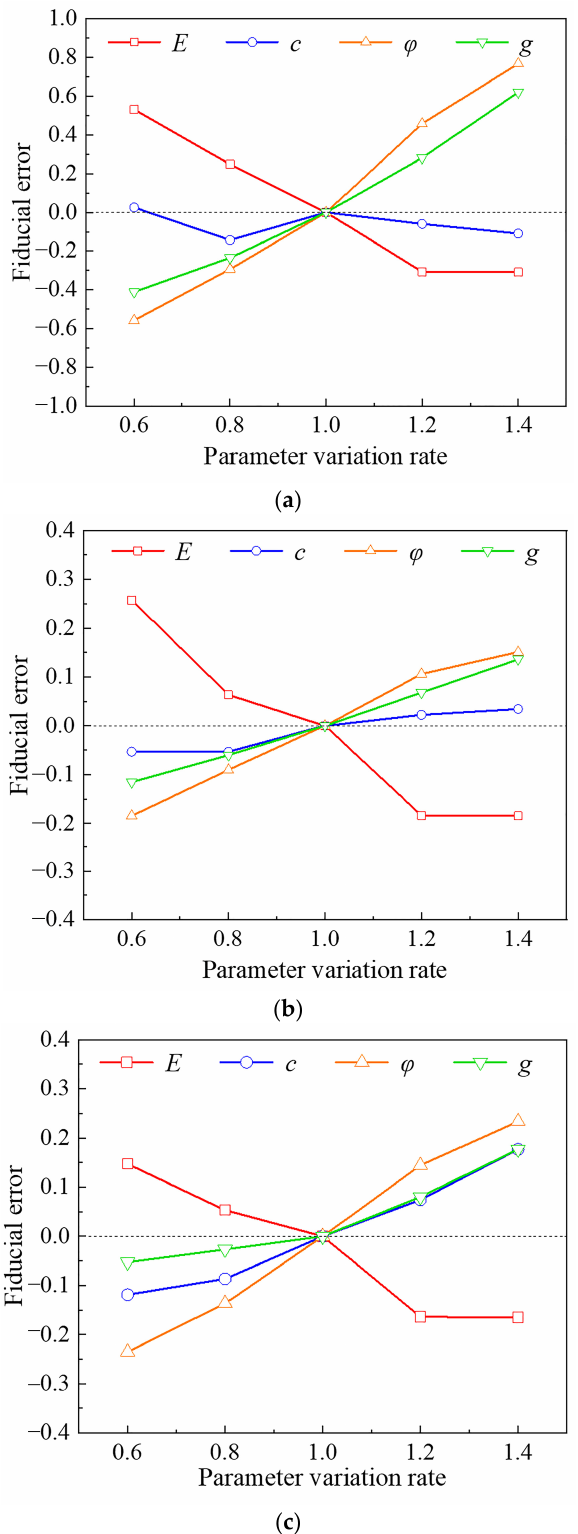
Figure 10. Key unit dynamic bending moment reference value error curve. ( a ) A1; ( b ) B1; ( c ) B2.